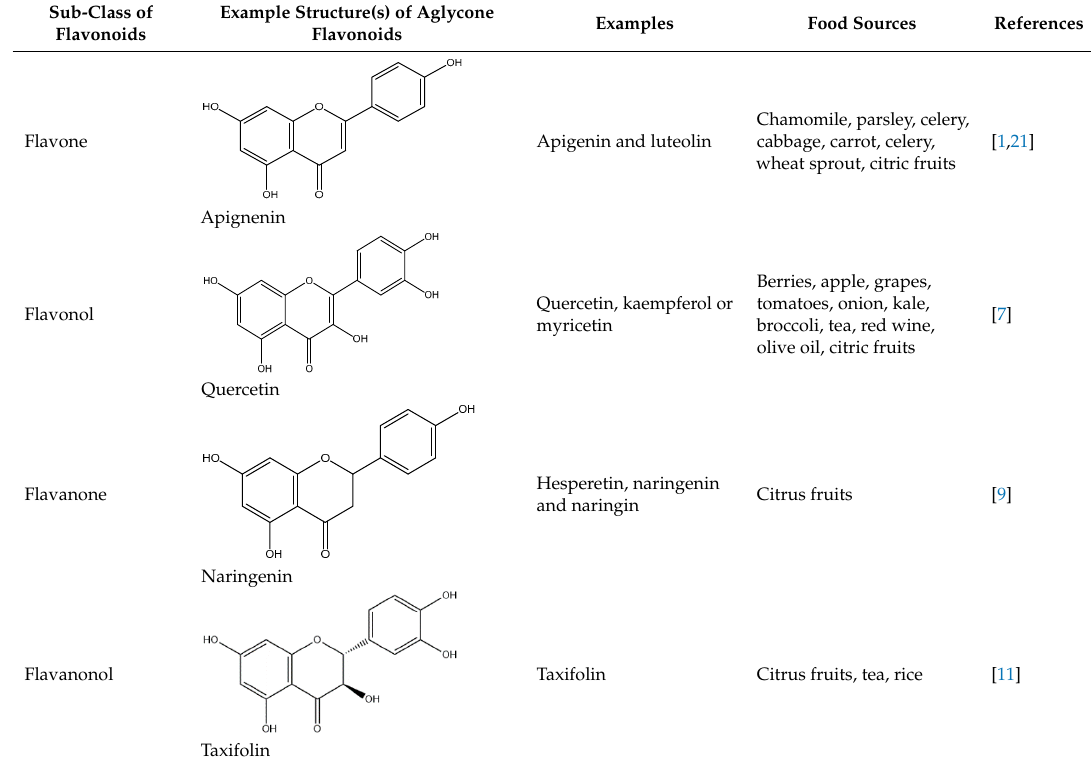
Table 1. Molecular structures, examples and food sources of flavonoids.